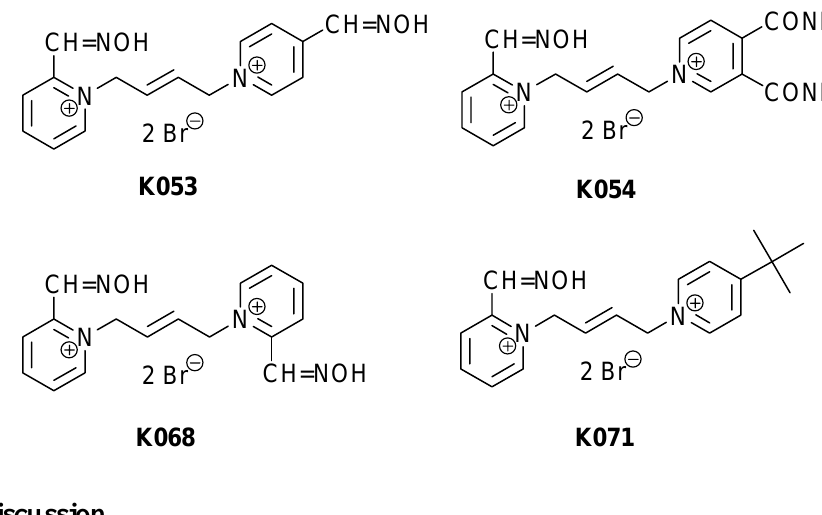
Figure 2. Chemical structures of novel acetylcholinesterase reactivators.